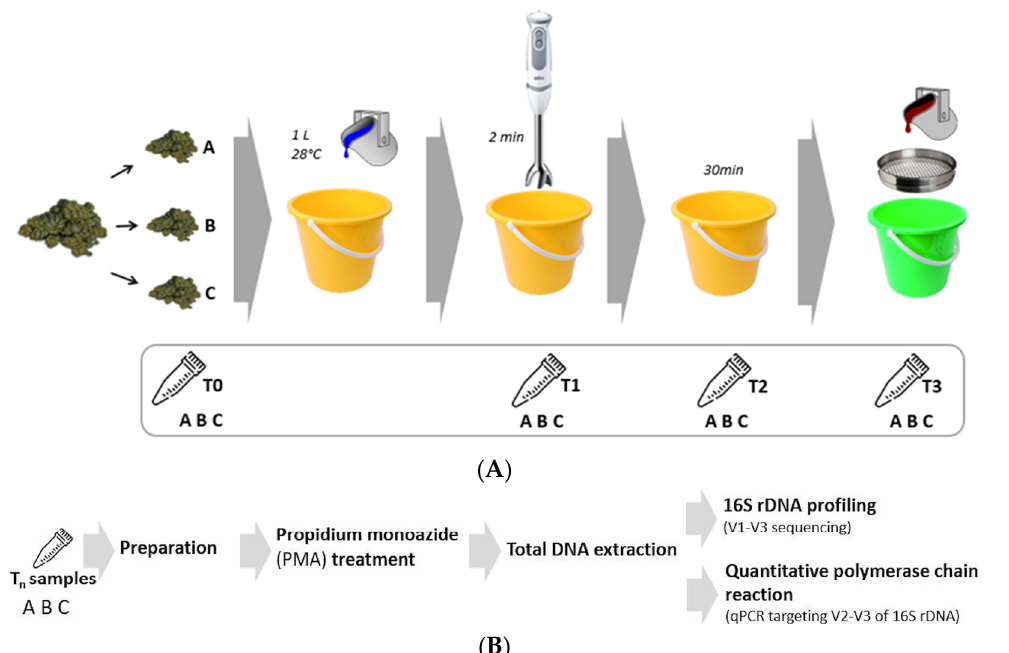
Figure 1. ( A ) Schematic workflow showing the different steps of the protocol used in this study to prepare equine feces for transplantation and the sampling points (Tn) for each subsample (A, B, C) along the procedure. Initial manure (T 0 ) was mixed with 1 L of lukewarm water and chopped for 2 min using an immersion blender to obtain a mixture (T 1 ), which was left uncovered during 30 min (T 2 ) and percolated through a sieve to obtain a fecal filtrate (T 3 ). ( B ) Diagram describing the analyses performed on each sample taken in duplicate at different time points (Tn = T 0 , T 1 , T 2 , T 3 ) during the fecal manipulation procedure for each subsample (A, B, C).